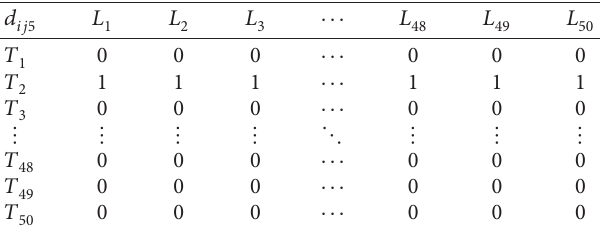
� [ d ] for tenants’ ij 6 6 50 × 50